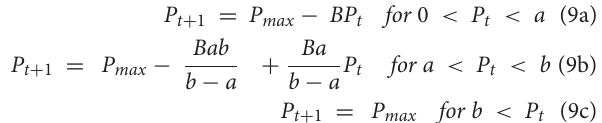
FIGURE 10 | Linear approximation to Equation (7), an inverse tent map with a